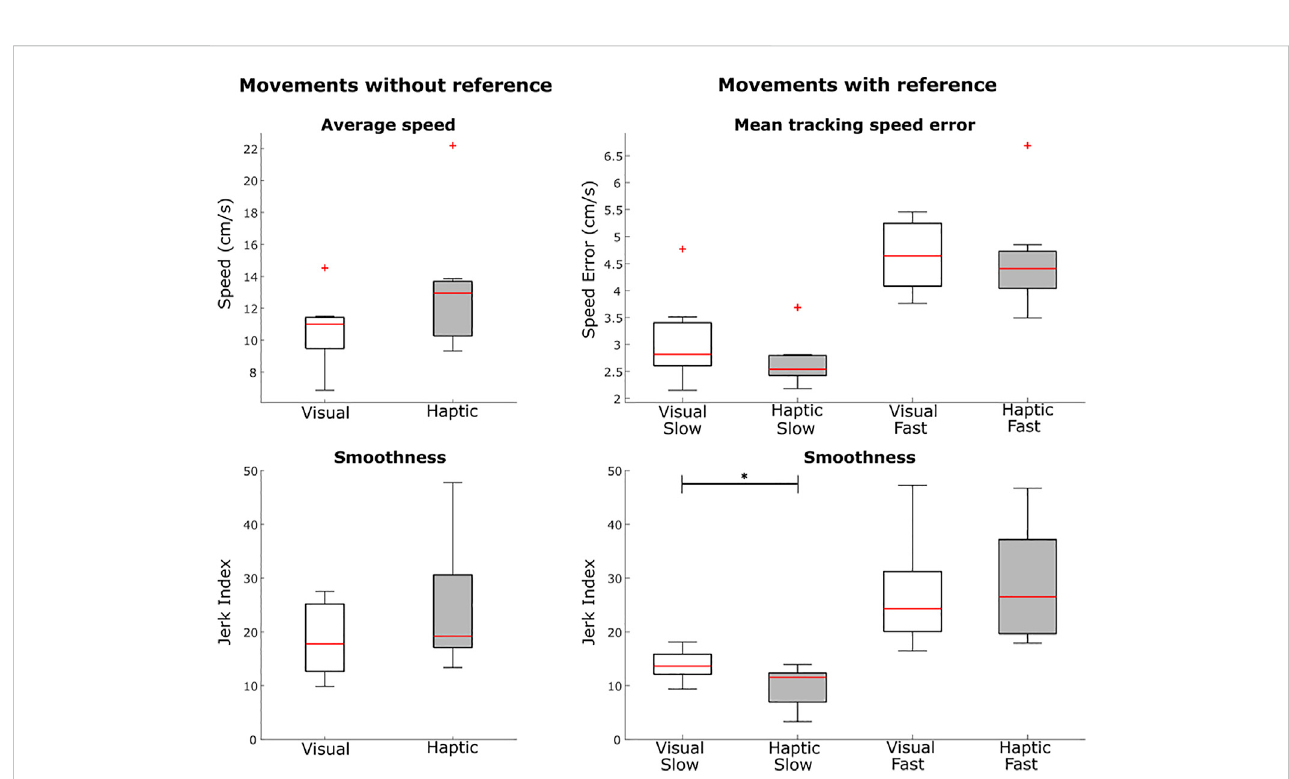
FIGURE 4 Experimental results measured in healthy participants regarding smoothness and velocity error in the path tracking serious game. Conditions varied for thepresenceorabsenceofavelocityreferenceandfortheenabledhapticorvisualfeedback.Theasterisksshowthesigni fi cancelevelofthecomparison(*for p <